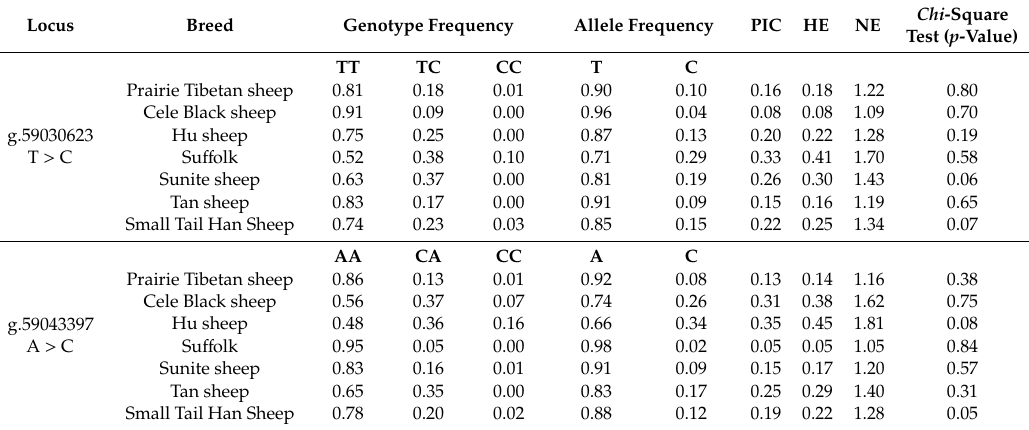
Table 3. Population genetic analysis of two loci of NLRP9 in seven sheep breeds.